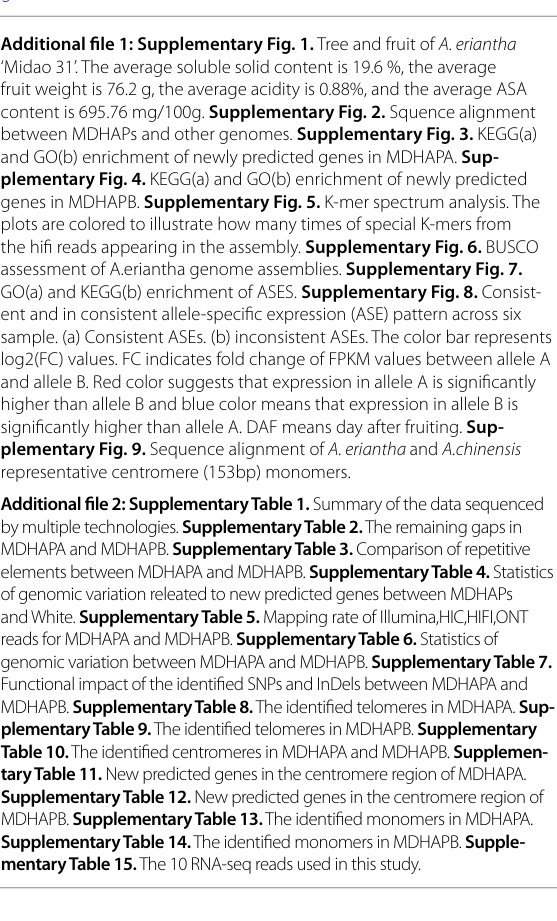
tary Table 11. New predicted genes in the centromere region of MDHAPA. Supplementary Table 12. New predicted genes in the centromere region of MDHAPB. Supplementary Table 13. The identified monomers in MDHAPA. Supplementary Table 14. The identified monomers in MDHAPB. Supple- mentary Table 15. The 10 RNA-seq reads used in this